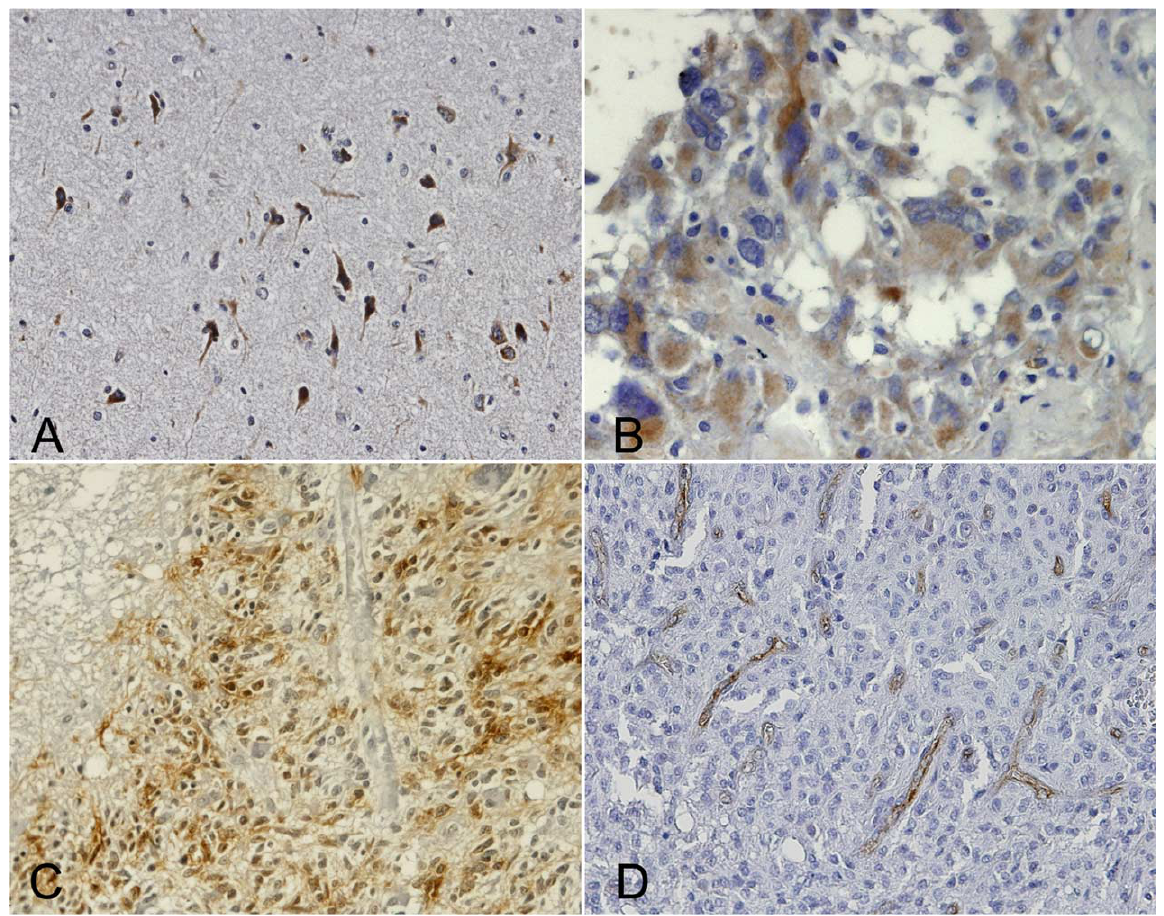
Fig. 1. Immunohistochemistry analysis of CD117 expression in: (A) peri-tumoral neurons (200 × ); (B) glioblastoma neoplastic cells (200 × ); (C) anaplastic oligoastrocytoma neoplastic cells (200 × ); (D) glioblastoma endothelial cells (200 ×